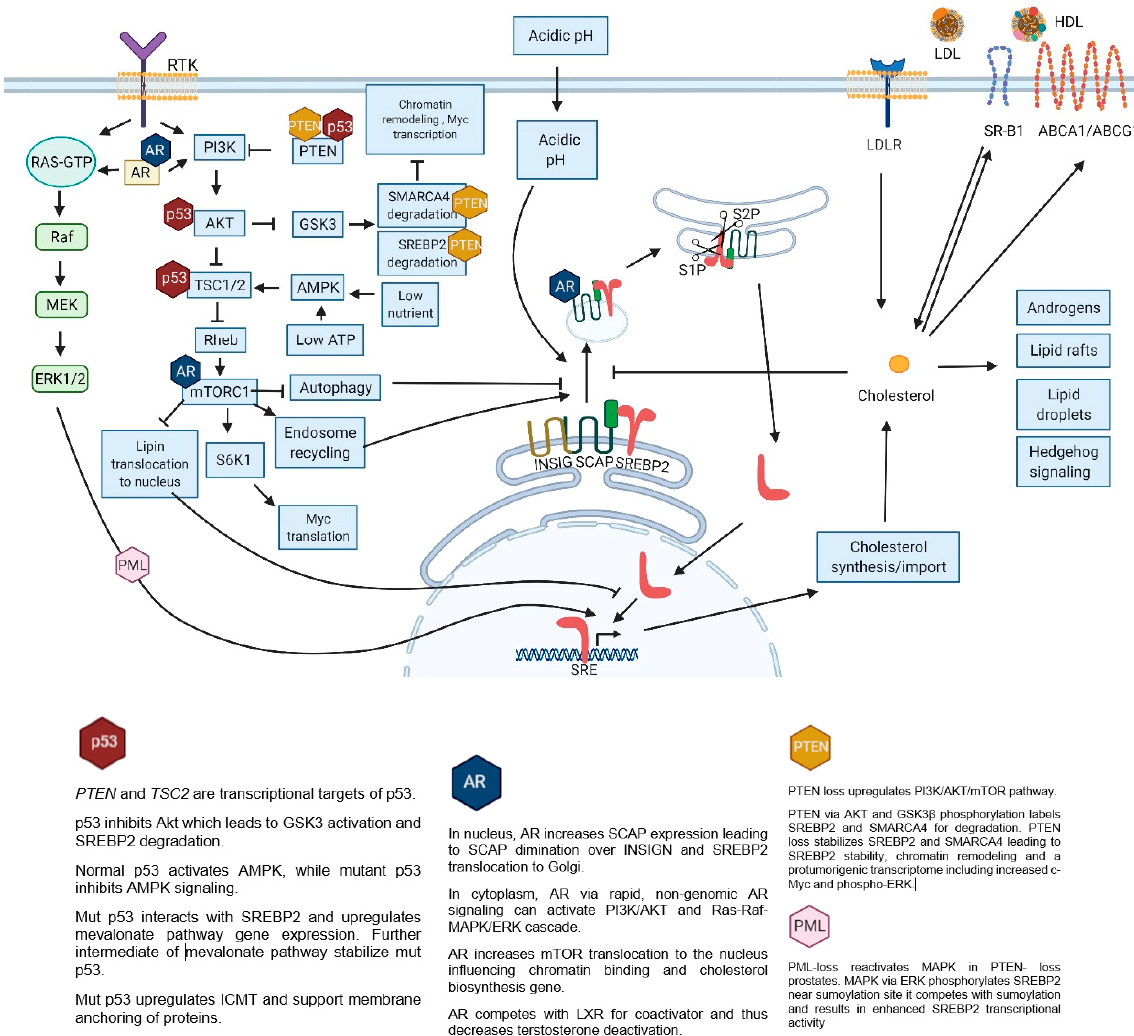
Figure 1. SREBP2 activation and regulation in physiologically normal cell. Hexagons indicate points of influence by commonly aberrant pathways in PC. Receptor tyrosine kinase (RTK); androgen receptor (AR); glycogen synthase kinase 3 (GSK3), high-density lipoprotein (HDL); low-density lipoprotein (LDL); low-density lipoprotein receptor (LDLR); ATP-binding cassette transporter A1 (ABCA1); ATP-binding cassette transporter G1 (ABCG1); scavenger receptor class B member 1 (SR-B1); insulin-induced gene (INSIG); SREBP cleavage-activating protein (SCAP); site-1 protease (S1P); site-2 protease (S2P); sterol regulatory element–binding protein-2 (SREBP2); sterol response element (SRE). Created with BioRender.com. (accessed on 5 September